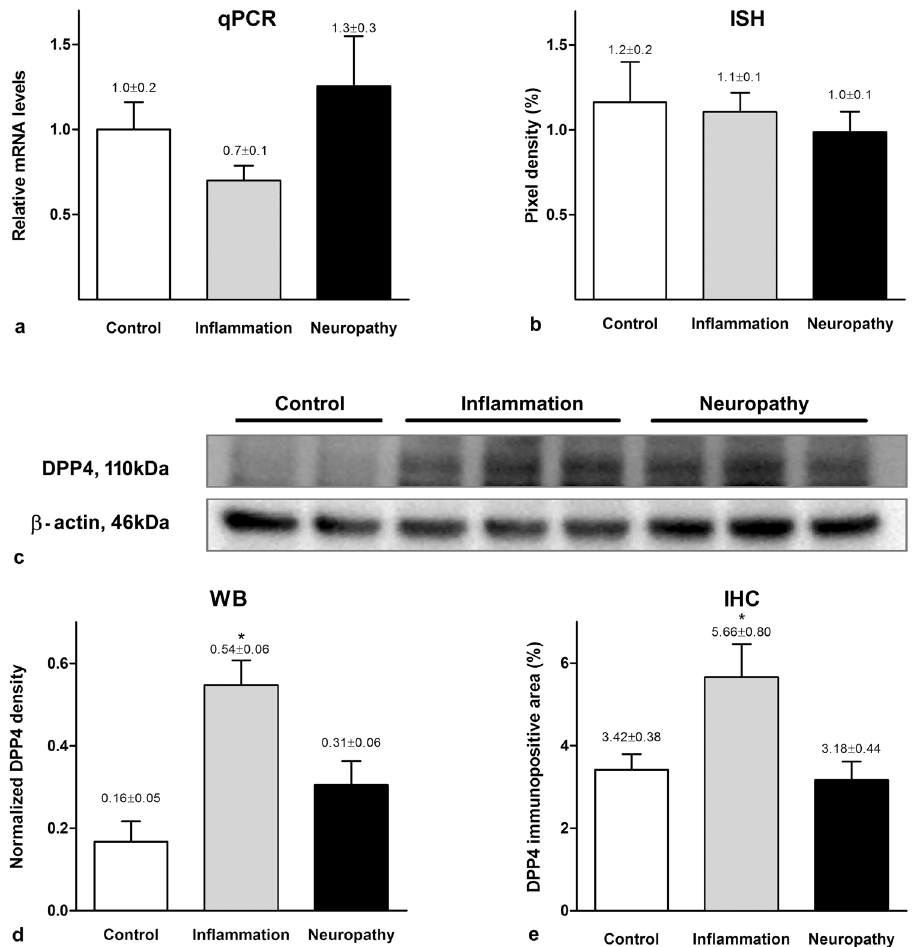
Figure 1. DPP4 mRNA and protein expression in the dorsal horn of control, carrageenan treated and neuropathic rats. DPP4 mRNA expression in the dorsal horn of the spinal cord assessed by qPCR ( a ) and in situ hybridization ( b ) did not show significant difference among the three experimental groups (mean ± SEM, n = 6–9, one-way ANOVA, P = 0.30 and P = 0.21 for qPCR and ISH, respectively). In Western-blot experiments goat DPP4 antibody labelled lane at 110 kDa in spinal dorsal horn lysates taken from naive, inflamed and neuropathic animals ( c ). The full gel is shown in Supplementary Figure S1. Significantly increased DPP4 protein levels were detected in carrageenan-induced inflammation measured both by Western-blotting ( d ) and quantitative immunohistochemistry ( e ). (Values are given as mean ± SEM, n = 7–10, one-way ANOVA followed by Holm-Sidac post hoc test: P = 0.023 for Western blot experiments and one-way ANOVA with Student- Neuman-Keuls post hoc test: P = 0.016 for